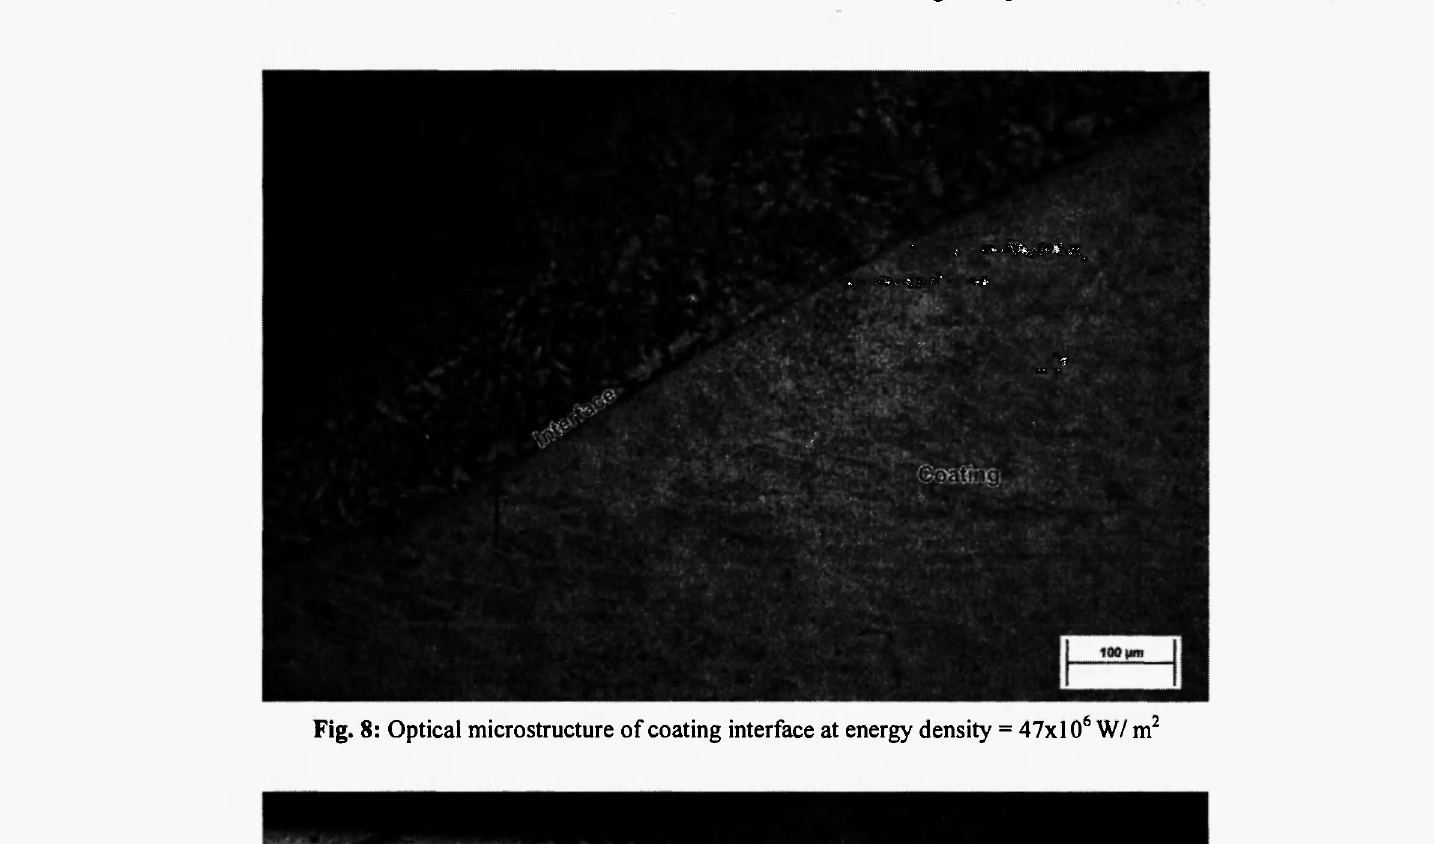
Fig. 8: Optical microstructure of coating interface at energy density = 47x10 6 W/ m 2